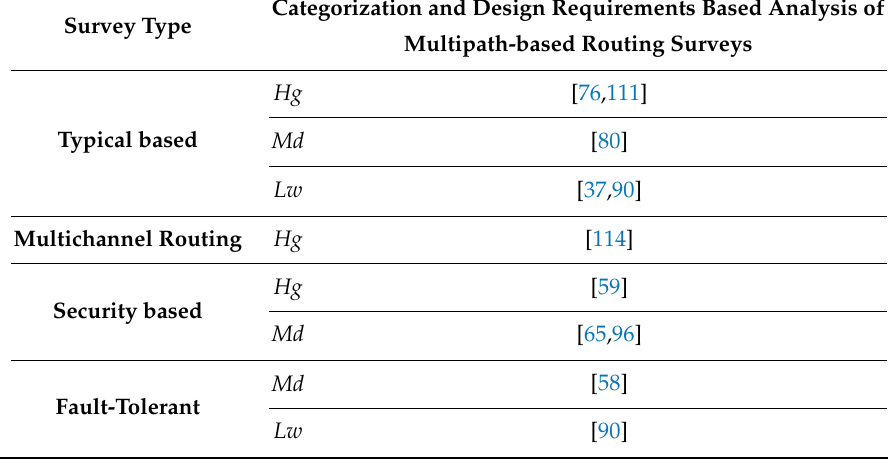
Table 8. Design analysis of multipath-based routing surveys in